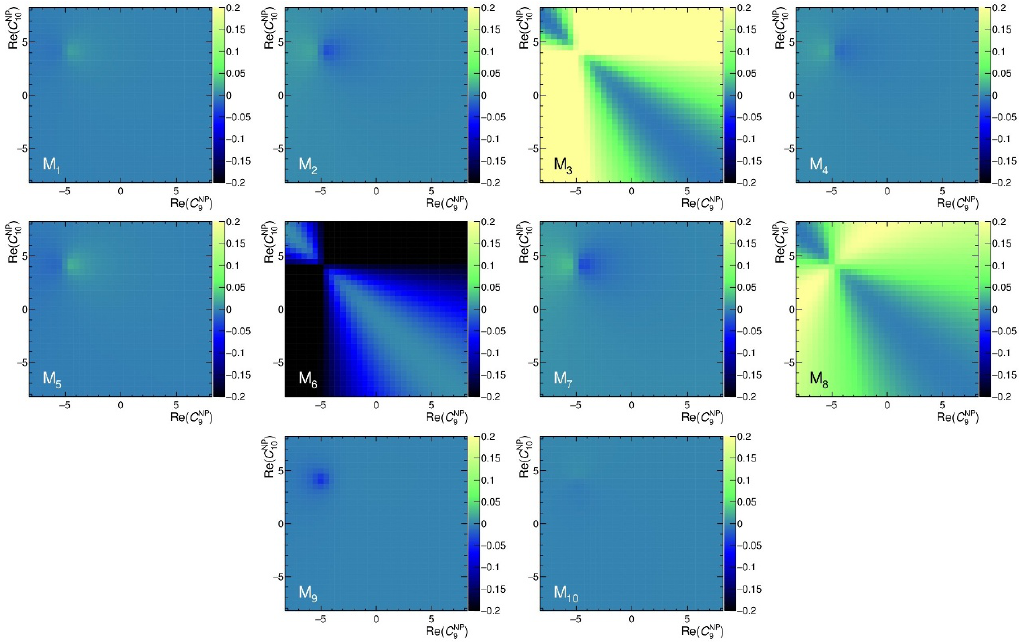
+ (cid:22) (cid:0) decay from their SM central 1 { M 10 of the (cid:3) b ! (cid:3) (cid:22)